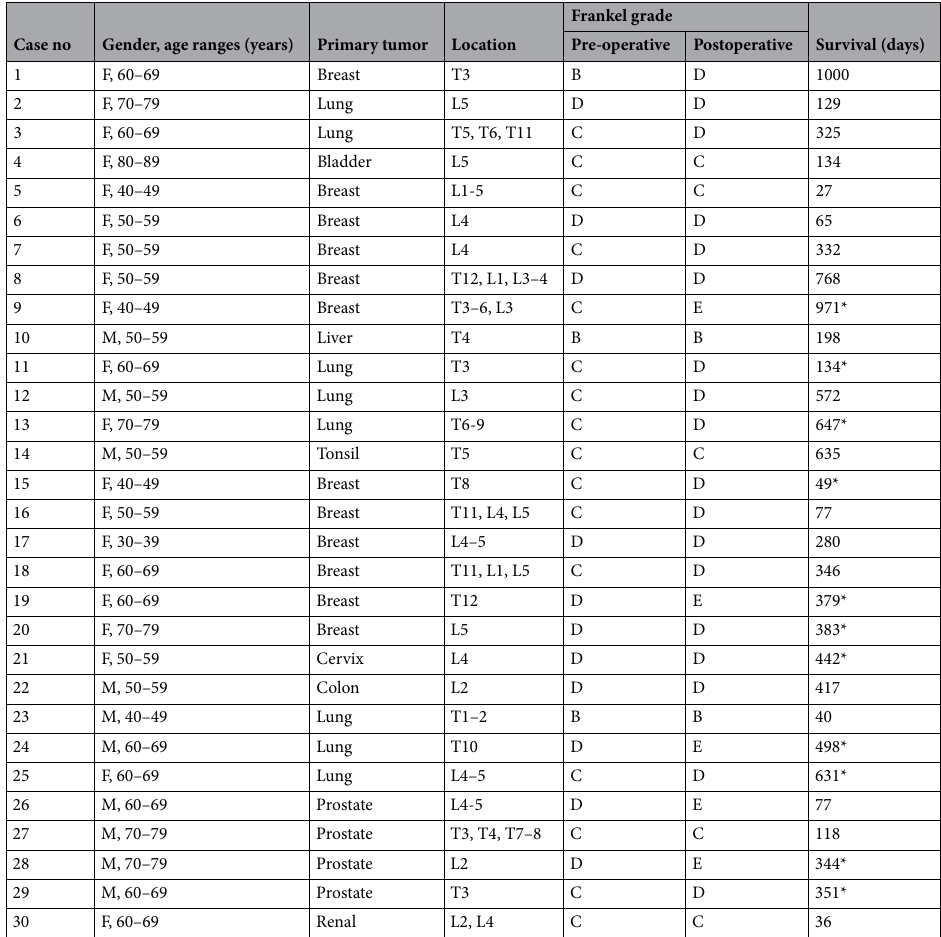
Table 1. Demographic and clinical data of 30 metastatic epidural spinal cord compression patients who underwent posterior decompression and stabilization with neither fusion nor anterior reconstruction. *Patient was still alive at the time of the most recent contact.